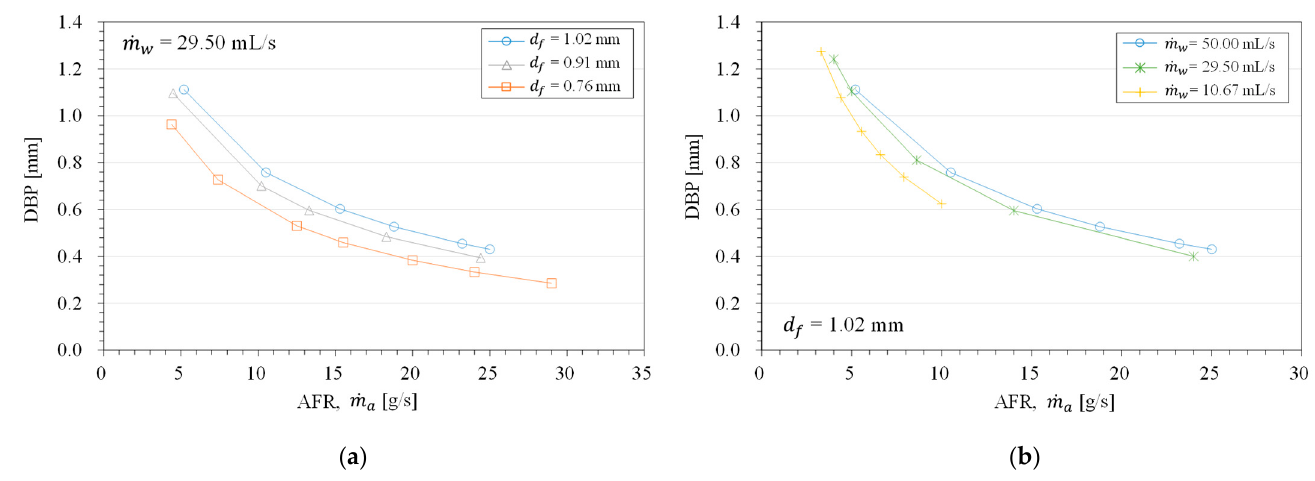
Figure 9. DBP as functions of the ( a ) focus diameter and ( b ) WFR.